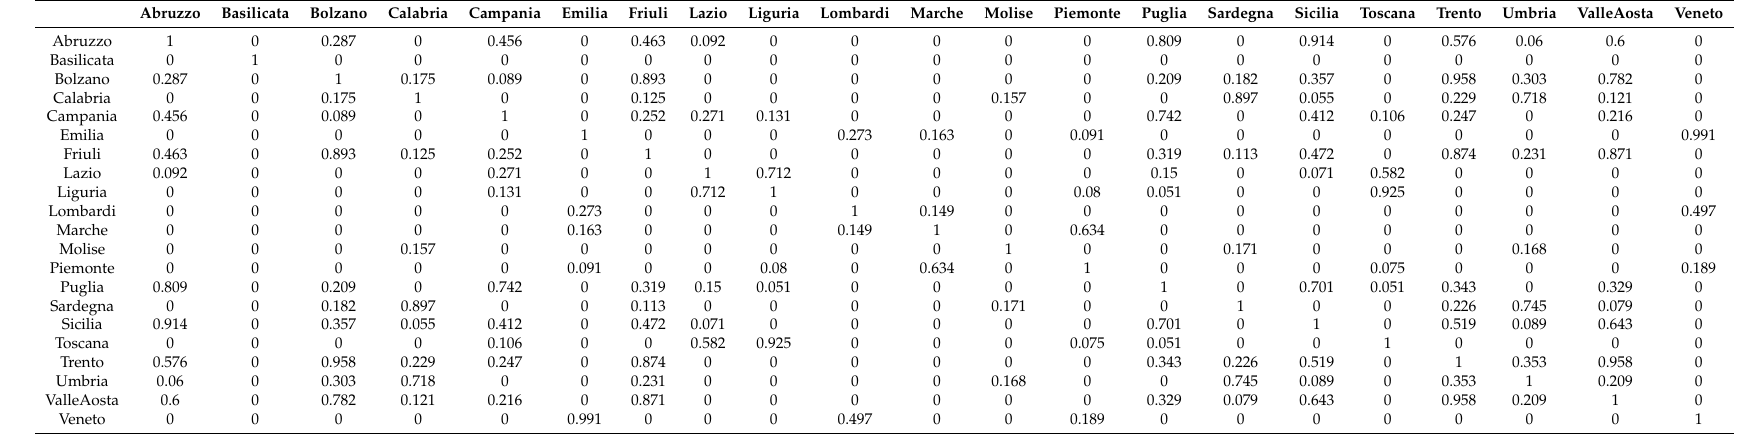
Table A2. Similarity values of Hospitalized with Symptoms network in the first